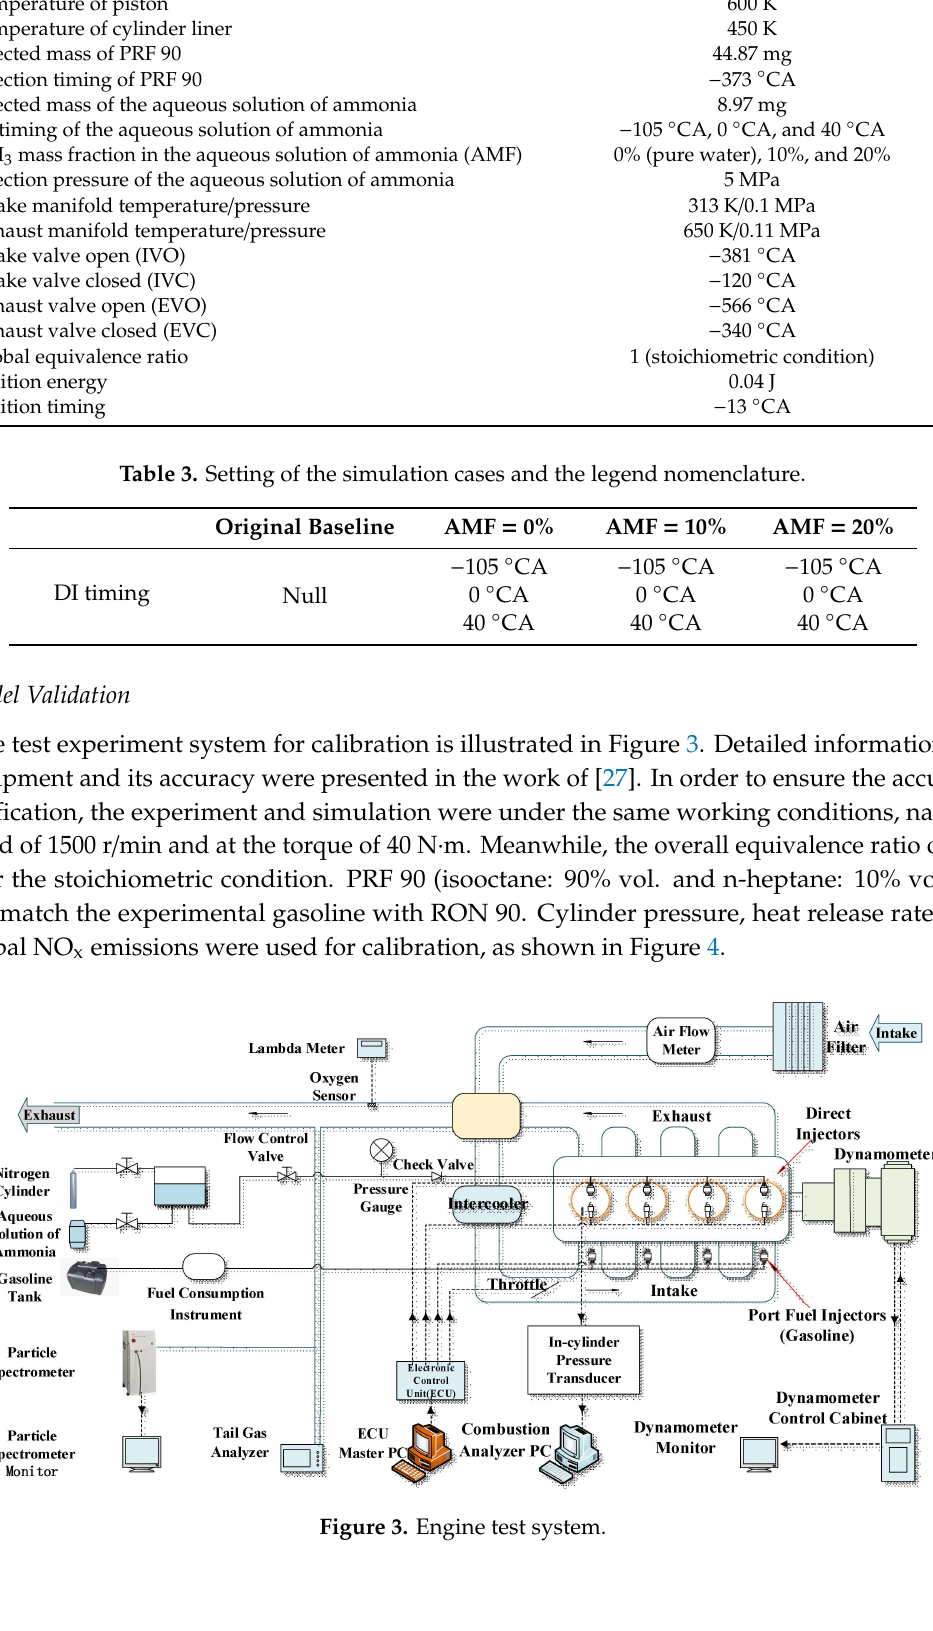
( c ) Figure 4. Comparison of calculated and measured ( a ) cylinder pressures, ( b ) heat release rates (HRRs), and ( c ) global NO x emissions. TDC, top dead centre. 3. Results and Discussion 3.1. Cylinder Pressure In Figure 5a, the DI event occurs before combustion (DI timing = −105 °CA). With AMF increasing, the peak pressure decreases first and then increases when AMF = 20%. The peak pressure change rate is −0.22%–0.37%. This is because that part of NH 3 is oxidized, compensating for the pressure drop caused by water. In Figure 5b, the DI event occurs during combustion (DI timing = 0 °CA). A significant delay (0.9 °CA) is observed. However, the pressure is without noticeable changes with the variation of AMF, which indicates no compensation for pressure by NH 3 addition. These two cases, DI timing = −105 °CA or 0 °CA, will cause lag of the phase angle corresponding to the peak pressure. Most of the components in the aqueous solution of ammonia are water, the local adiabatic flame temperature decreases in the cylinder due to the phase change of water, which is an endothermic process. Further, the temperature dropping further affects the chemical reaction rate. This is why the crank angle phase is delayed. Water direct injection could promote the formation of a highly humid air/fuel mixture, which inhibits the advance and spread of the flame front. Especially when the injection timing is near the combustion phase (DI timing = 0 °CA), it is likely to cause peak pressure decrease, peak phase angle delay, incomplete combustion, and power decrease as a result of more interference. In Figure 5c, because the direct injection happens after the combustion phase